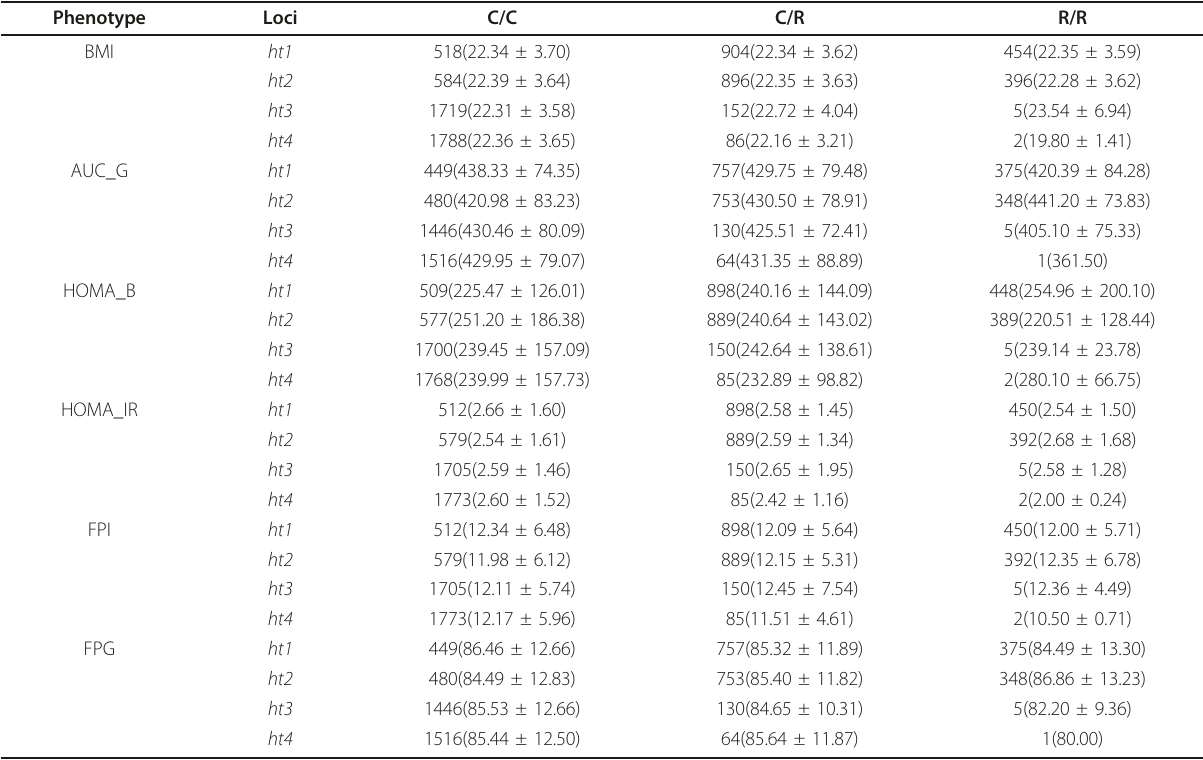
Table 4 MTNR1B haplotypes ’ genotype distribution, means and standard deviations of various phenotypes for GDM